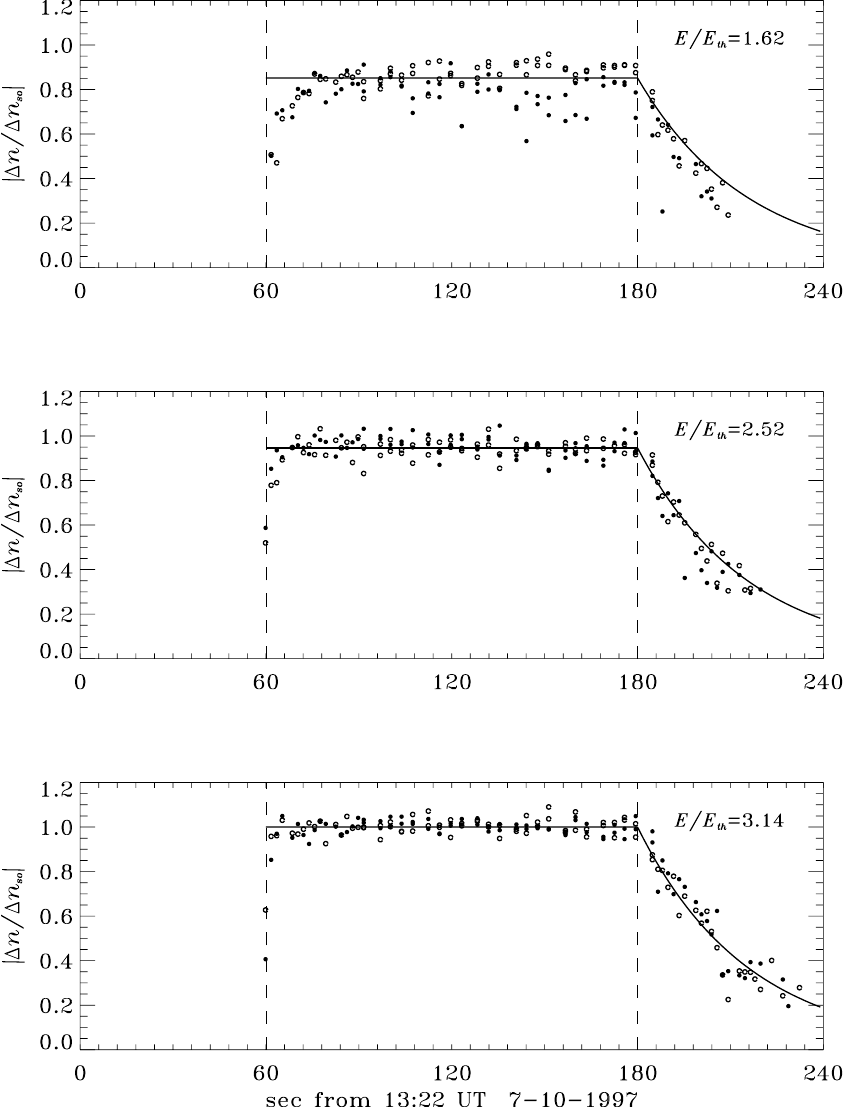
Fig. 3. Temporal variations of the den- sity perturbation normalized to the satu- ration level observed in the central gates are presented for three ratios of pump electric field to the threshold field. Ver- tical lines at the times 13:23UT and 13:25UT show the moments of switch- ing on and switching off of the HF heating. The horizontal line marks the mean value of the density perturba- tions during the heating and represents the saturation level. The solid line af- ter 13:25UT shows the density decay which is deduced from the fitting of the observational points and follows the ex- ponential law of Eq.